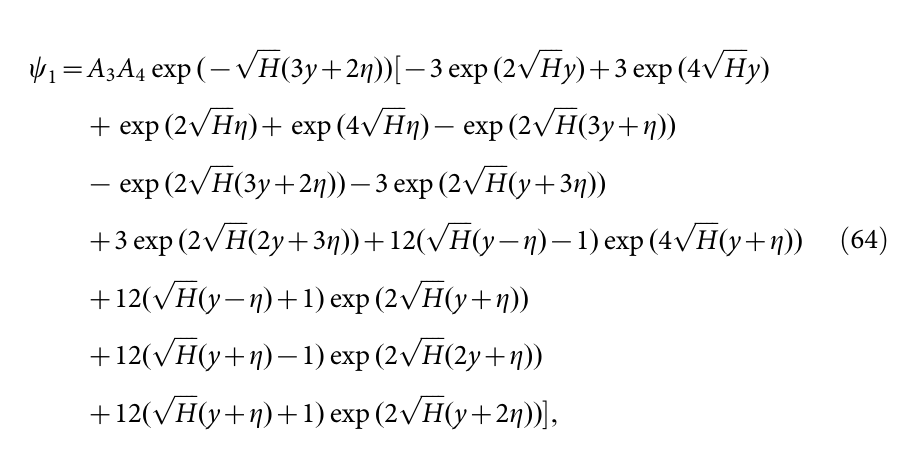
Figure 17. Plot of concentration g for homogeneous reaction parameter K with E ~ 0 : 2 , t ~ 0 : 1 , x ~ 0 : 1 , Sc ~ 1 : 5 and M ~ 2 .